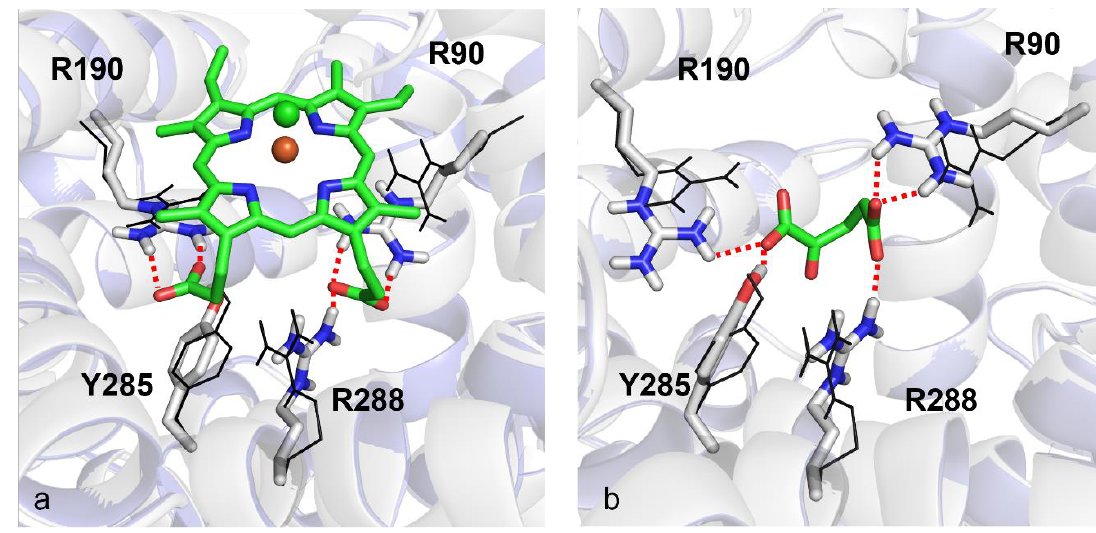
Figure 8. Induced-fit molecular docking. Panels ( a ) and ( b ) show the top-scored poses returned from docking analyses for hemin and 2-oxoglutarate within the OGC homology model built by using the bovine crystallized AAC1 as a template (PDB_ID: 1OKC). Red dotted lines indicate hydrogen bonds. Fe 3+ and Cl − ions are depicted as orange and green spheres, respectively. Black wireframes show the initial positions of key residue side-chains before induced-fit docking simulations.